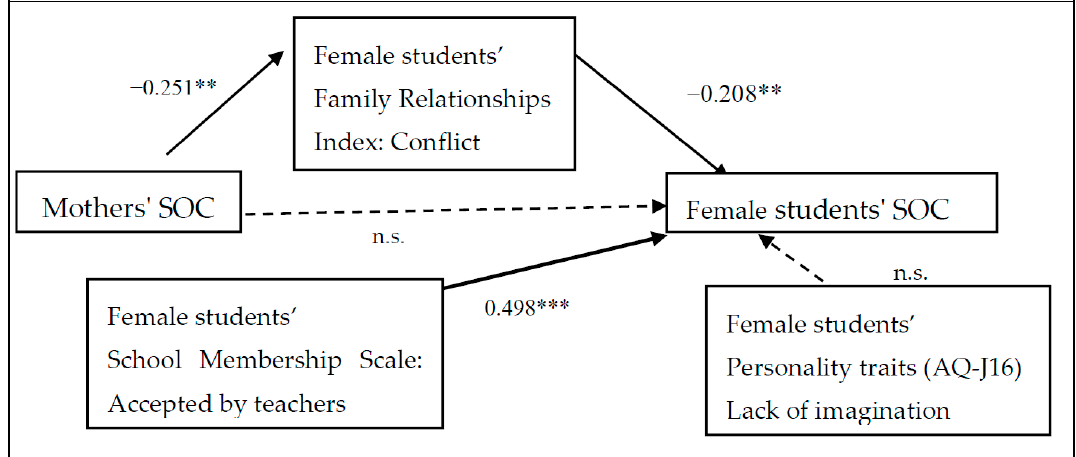
Figure 2. Female students’ SOC path diagram. RMSEA = 0.064, CFI = 0.908, χ 2 /df = 2.31. *** p < 0.001, ** p < 0.01.